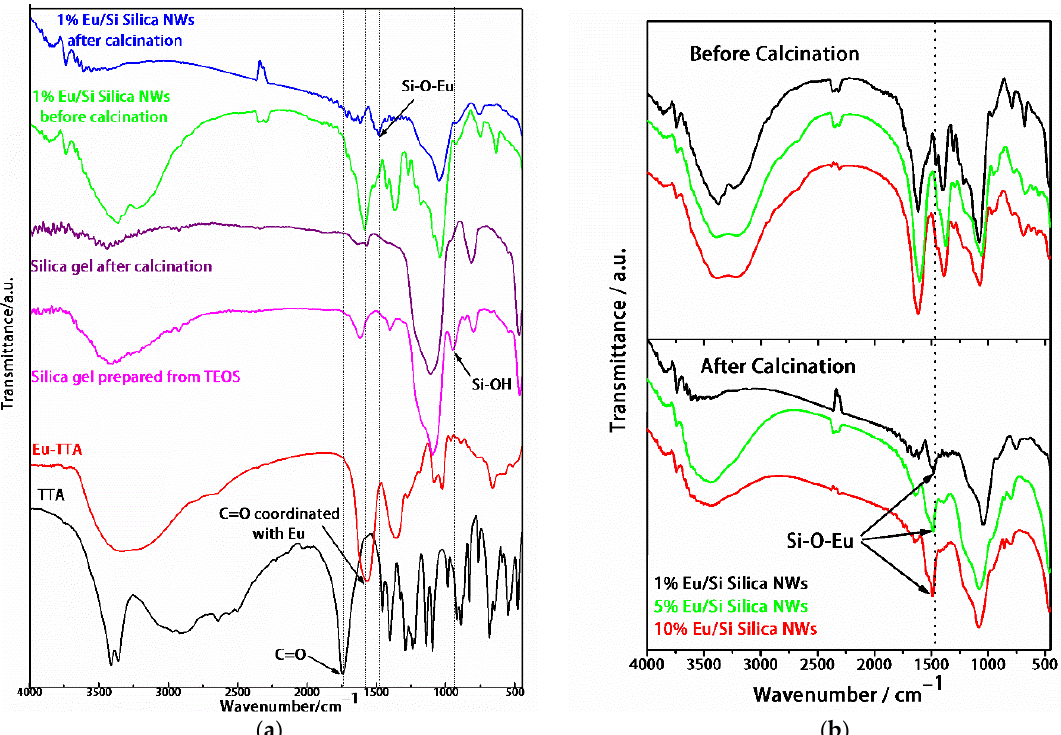
Figure 5. FT-IR spectra of TTA, Eu 3+ -tartrate, silica gel (before and after calcination), 1% Eu/Si SiO 2 NWs (before and after calcination) ( a ) and Eu 3+ -doped SiO 2 NWs prepared in different doping content at 25 °C before and after calcination ( b ).